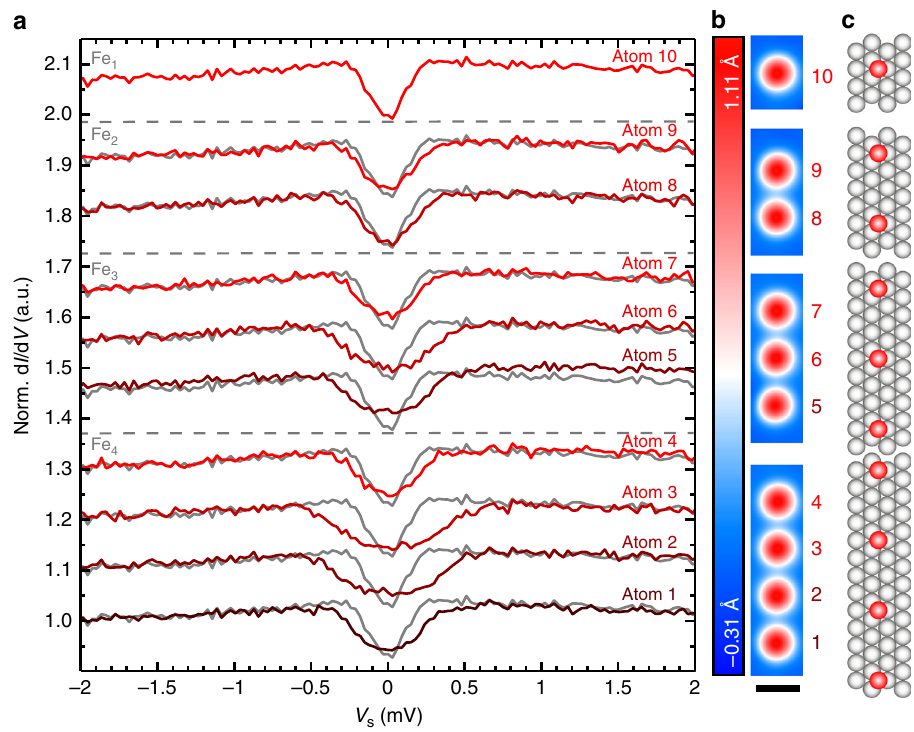
Fig. 1 ISTS of bottom-up Fe N chains of different numbers N of atoms. a ISTS spectra taken on top of an isolated Fe atom (Fe 1 , 10) and on the Fe atoms inside Fe 2 (8, 9), Fe 3 (5, 6, 7), and Fe 4 (1, 2, 3, 4) chains with d NN = 4 a . For comparison, the spectrum of the isolated Fe 1 is shown in gray behind all other spectra. All spectra were normalized by dividing by a substrate spectrum. ( V stab = − 6 mV, I stab = 3 nA, V mod = 40 μ V). b , c STM topographs and schematic ball models where the red and gray spheres represent the Fe and surface Pt atoms, respectively, of all chains investigated in ( a ) ( V s = − 6 mV, I stab = 0.5 nA). The black scale bar below ( b ) has a length of 1